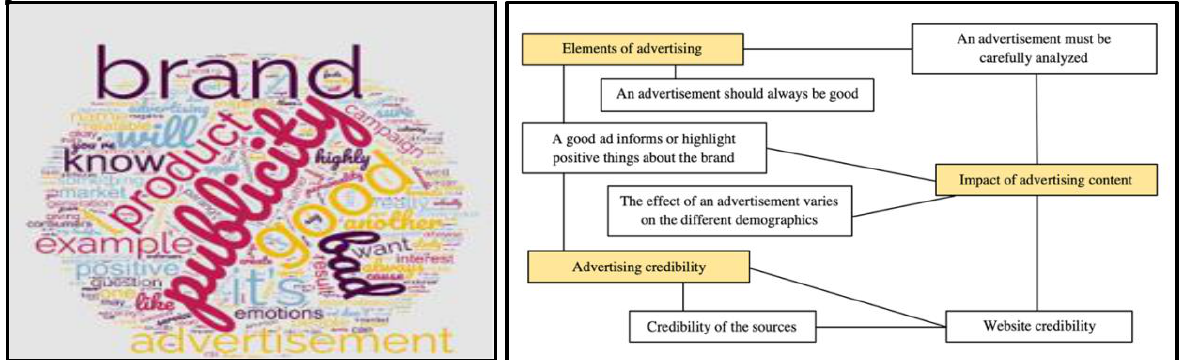
Figure 16: Thematic Map of Brand Advertisement Leading to Good or Bad Publicity